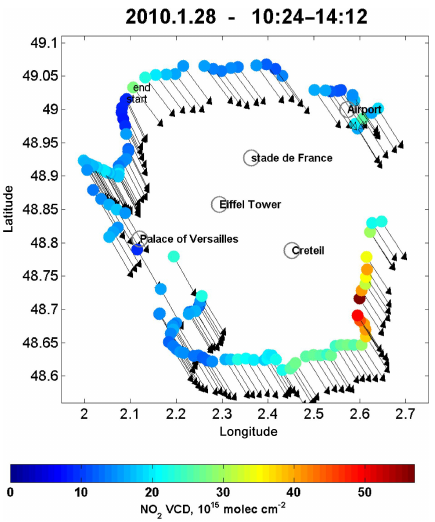
Figure 8. NO 2 VCDs measured on 28 January 2010. On this day locally enhanced NO 2 VCDs are found on the upwind side of the circle.